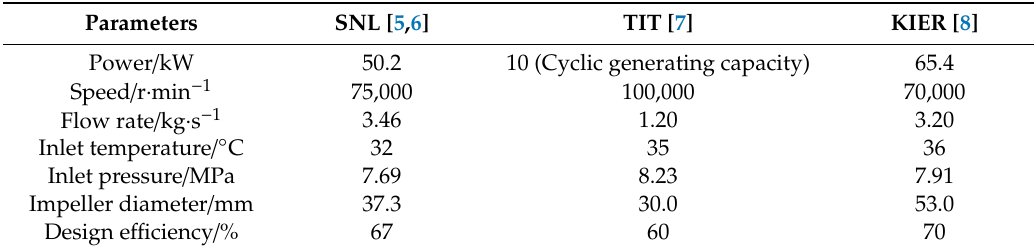
Table 1. The key parameters of the S-CO 2 centrifugal